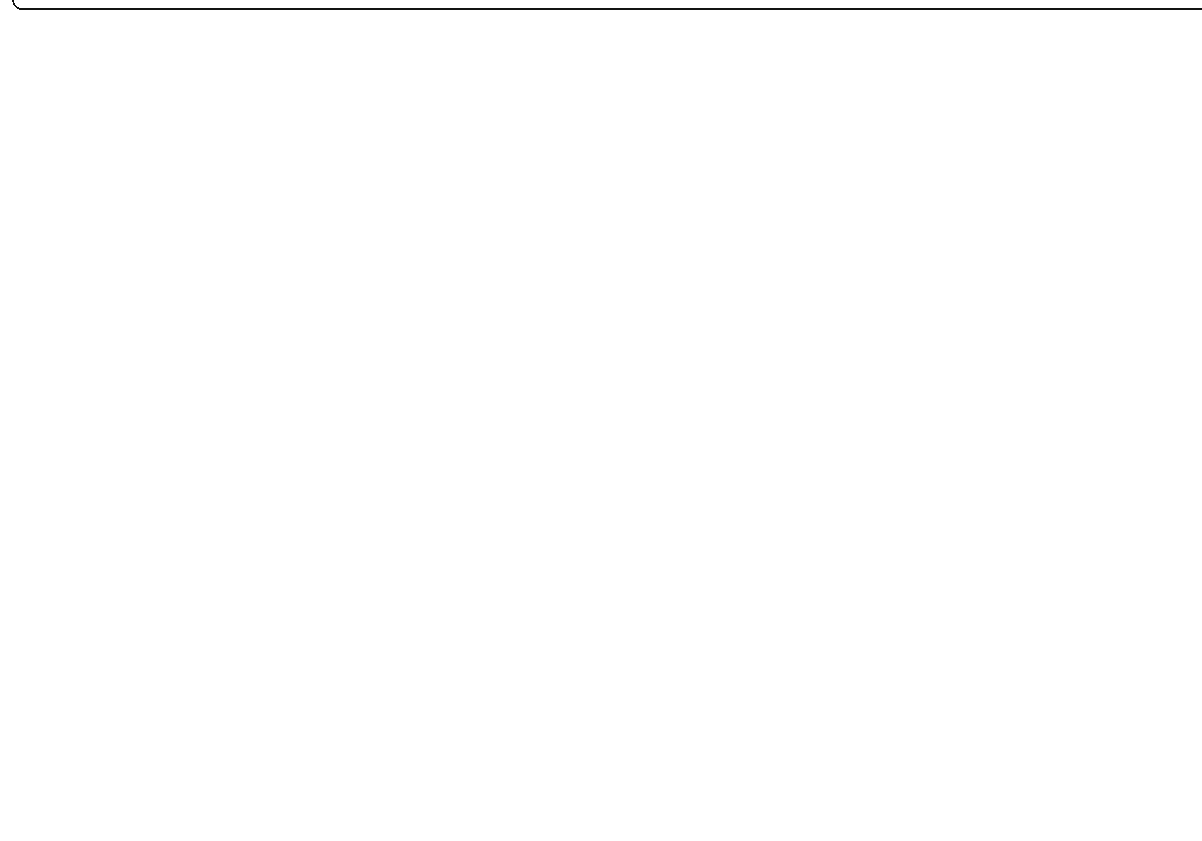
Fig. 10 Interference in the levels of phospho-eIF2 α in BM cells at 250 μ g/mL of Radix Astragali and Radix Angelicae Sinensis treatment. The expression levels of eIF2 α and phospho-eIF2 α in BM cells were determined by Western blot analysis. β -actin was used as an internal control. The quantified results are presented in a bar chart. Data are presented as the mean ± SD, n = 3. * P < 0.05 and ** P <